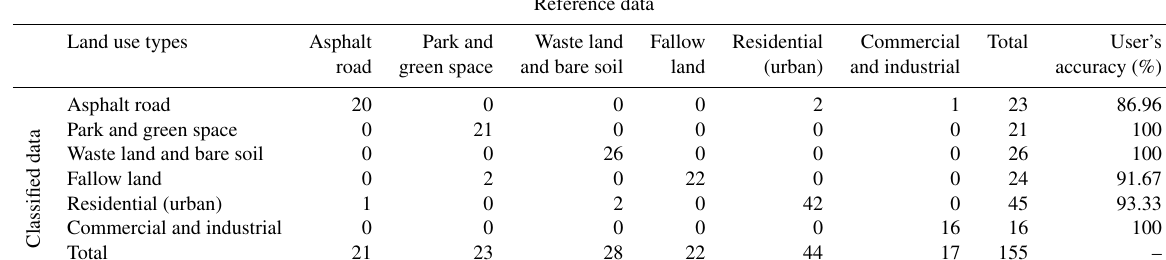
Table 6. Error matrix used to assess the accuracy of a classification of the 6 August 2009 Landsat TM image.